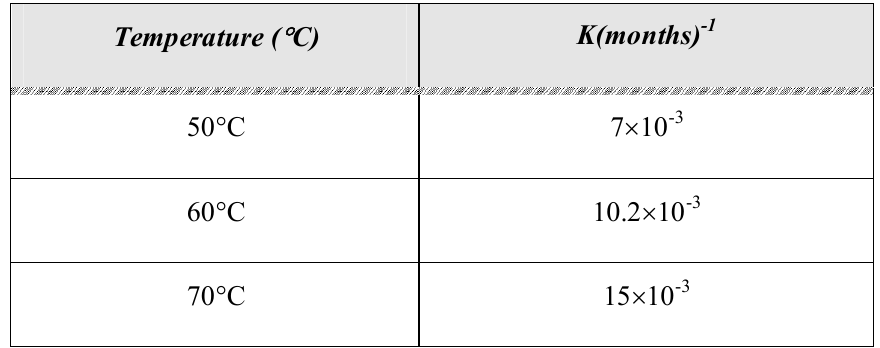
Table (7): Rate constants of degradation of captopril using the selected formula at different